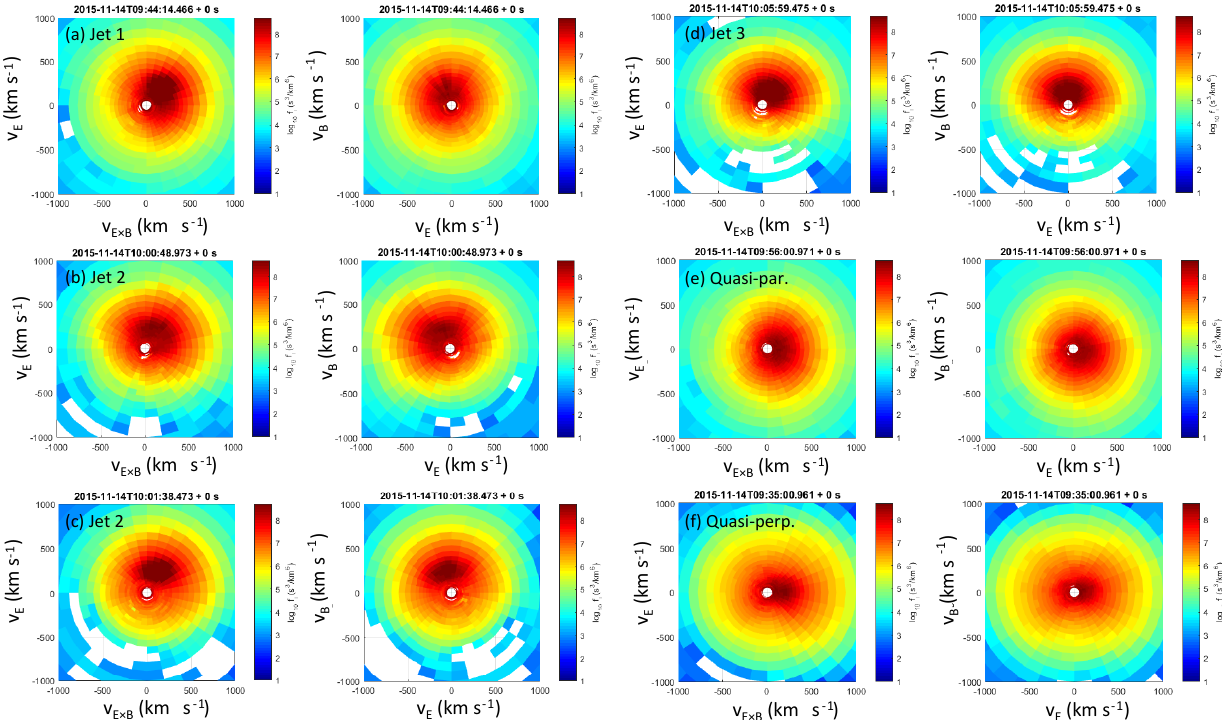
Figure 4. Ion distribution functions in the planes formed by the direction of the local magnetic field B , and E × B and E ⊥ , respectively. Distributions are shown for jets no. 1–3, and from the quasi-parallel and quasi-perpendicular magnetosheath outside of jet